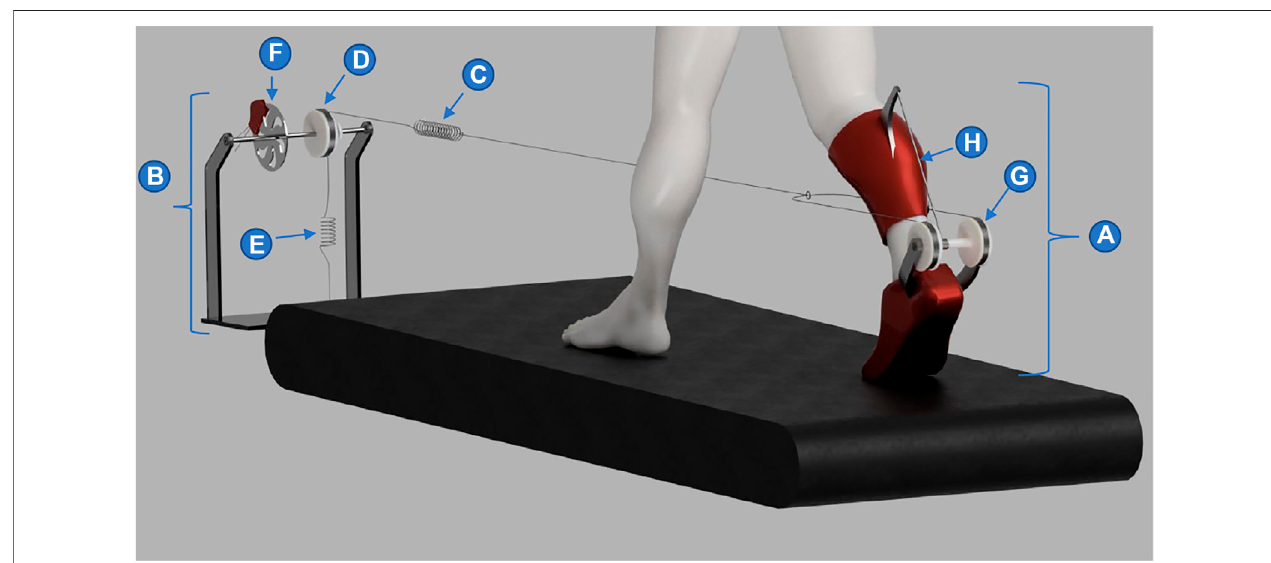
FIGURE 1 | AN-EXTRA-Push mechanical design. A lightweight orthosis (a) is worn by the user. It is connected to a braking and pretentioning module (b) using an elastic tendon (c). The braking and pretensioning module consists of a pulley (d), a constant force spring (e) and a brake (f). On the foot part of the orthosis a three spool structure (g) is mounted. It connects the elastic tednon (c) with a rigid tendon (h) attached to the shank part of the orthosis.